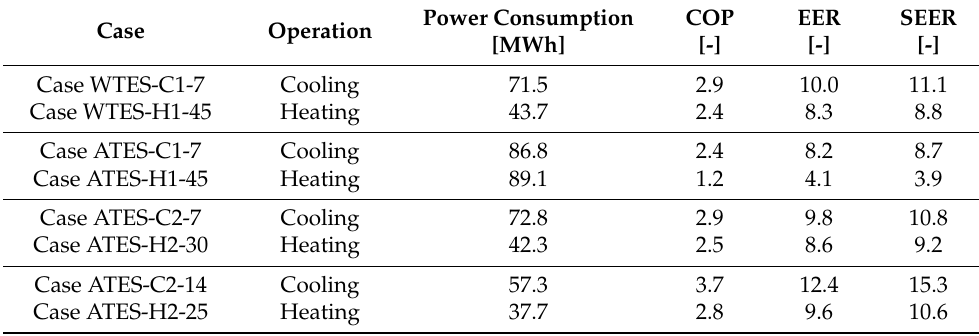
Table 5. Seasonal power consumption and energy